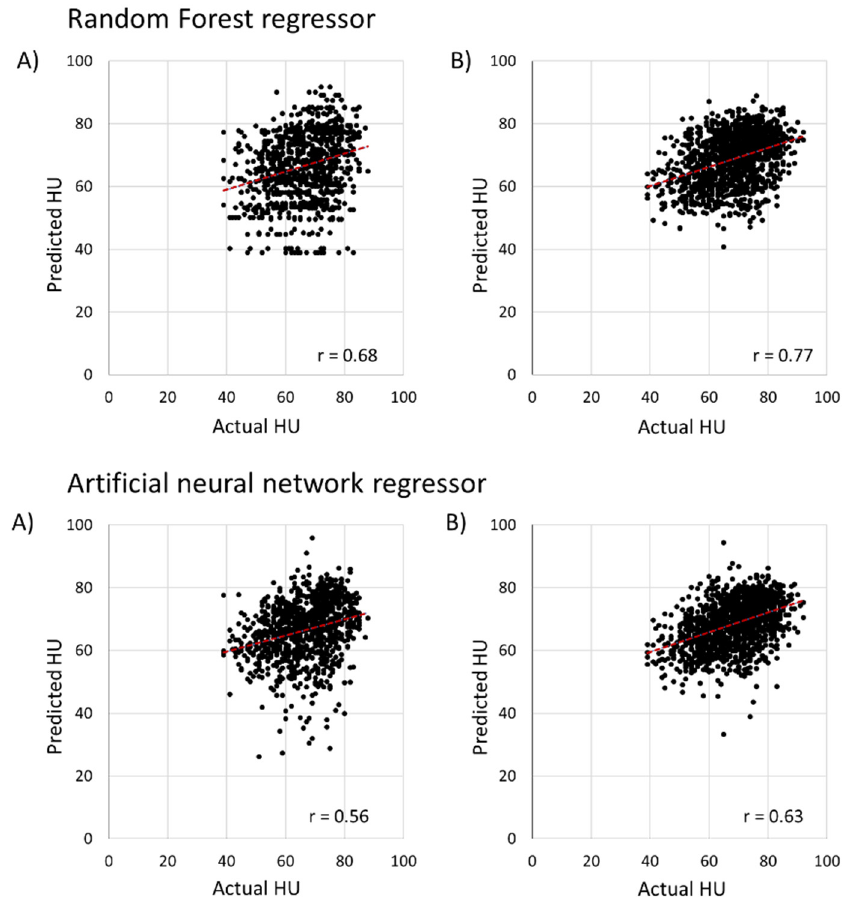
Figure 11. The result of general machine learning (RF and ANN regressor) for predicting HU weight loss data: ( A ) the results without data augmentation for random forest and artificial neural network regressor; ( B ) represents the results with data augmentation for random forest and artificial neural network regressor.